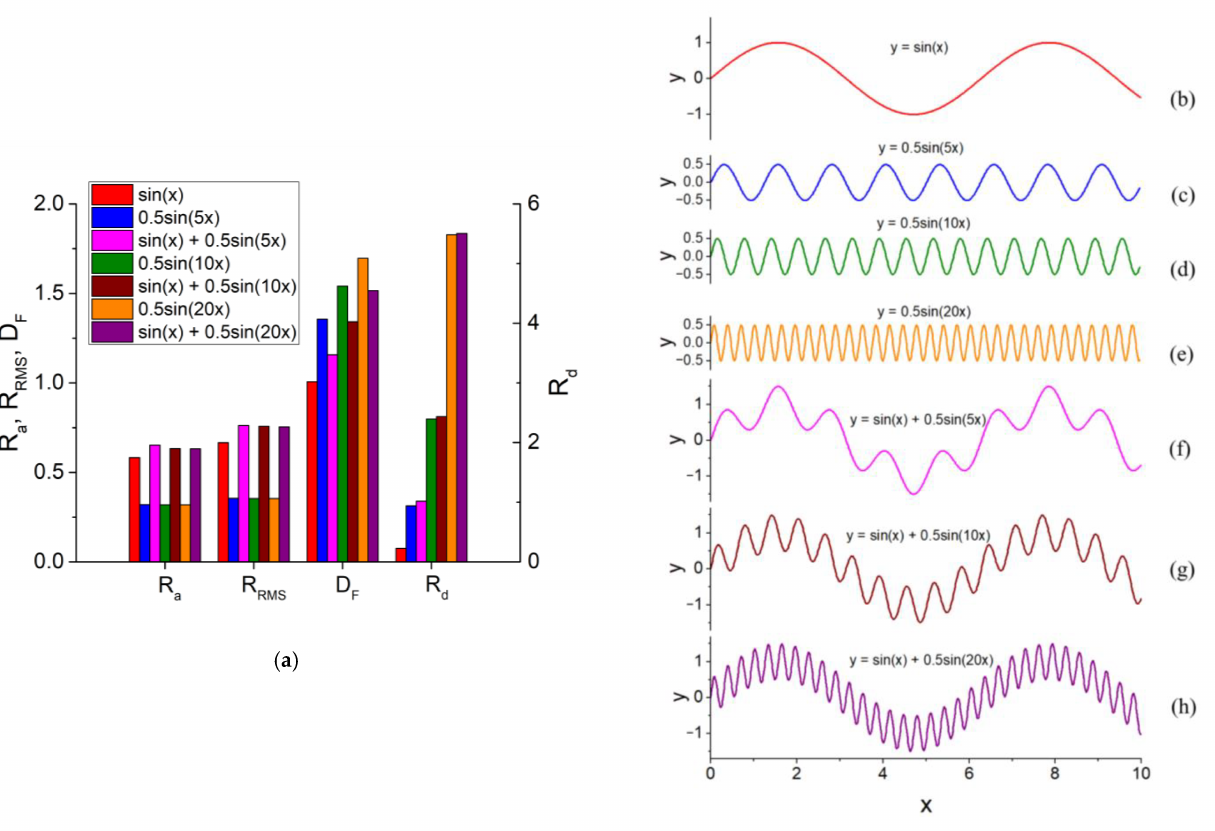
Figure 12. The R a ( a ), R d ( b ) and D F values ( c ) versus in-plane plastic strains of specimen subsections.